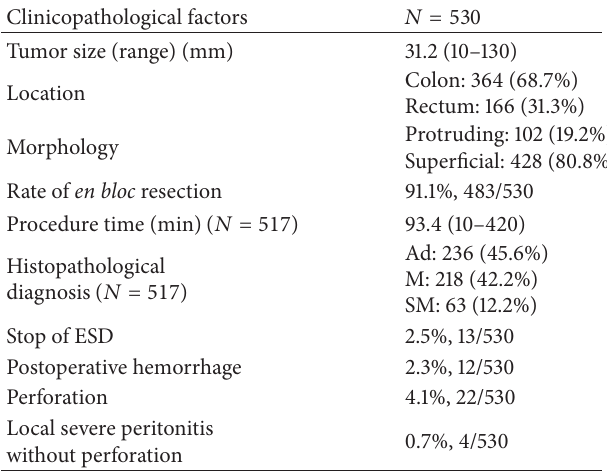
Table 1: Clinicopathological factors of 530 colorectal ESDs in our